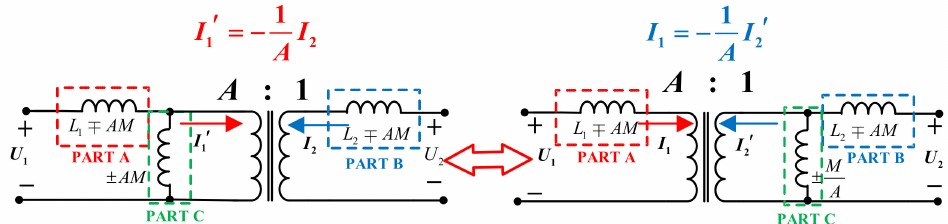
Figure 5. Equivalent circuit of the LCT from constant voltage to constant voltage.